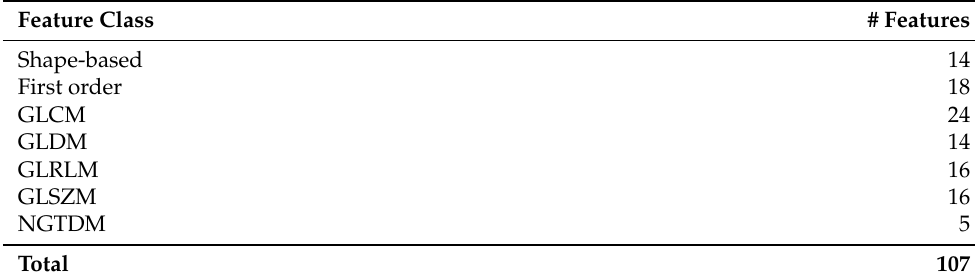
Table 3. Extracted radiomics feature